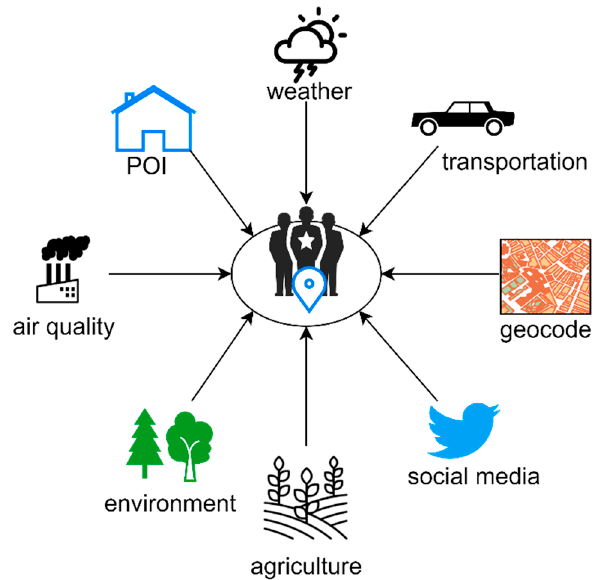
Figure 1. Location-linked data.